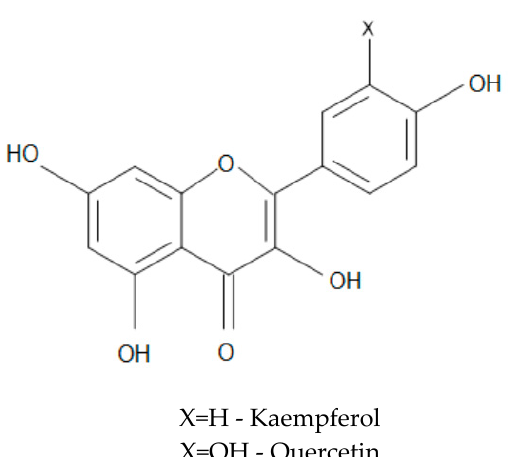
Figure 8. Chemical structure of flavonoids.